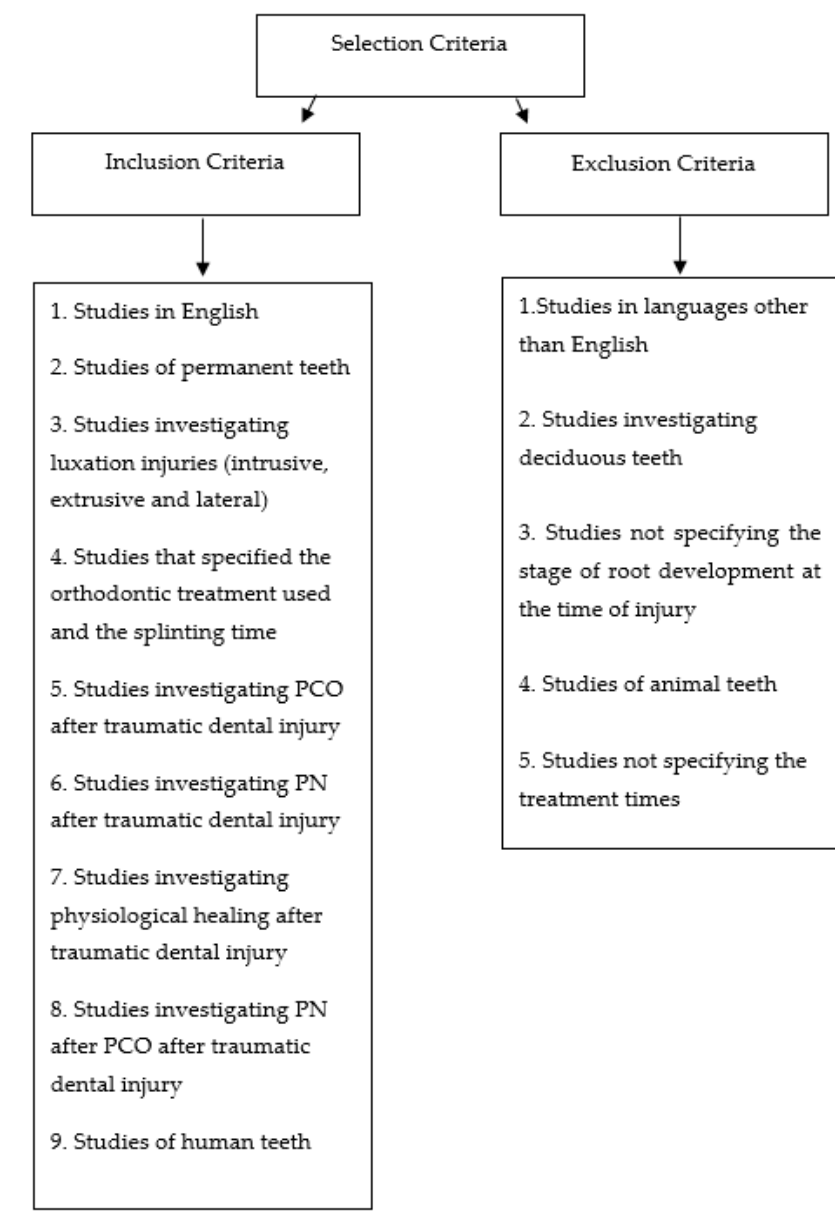
Figure 1. The figure contains either inclusion and exclusion criteria formulated for